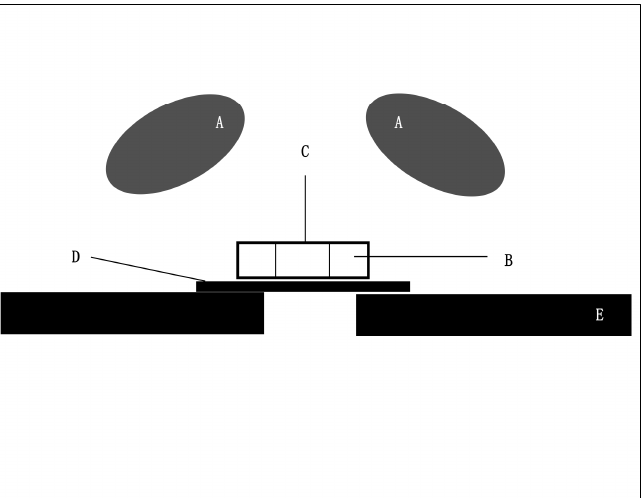
Figure 1. Scheme of the experimental set-up. ( A ) Cameras, ( B ) Dentin/Teflon mold, ( C ) Sample, ( D ) Glass plate and ( E ) Sample holder.